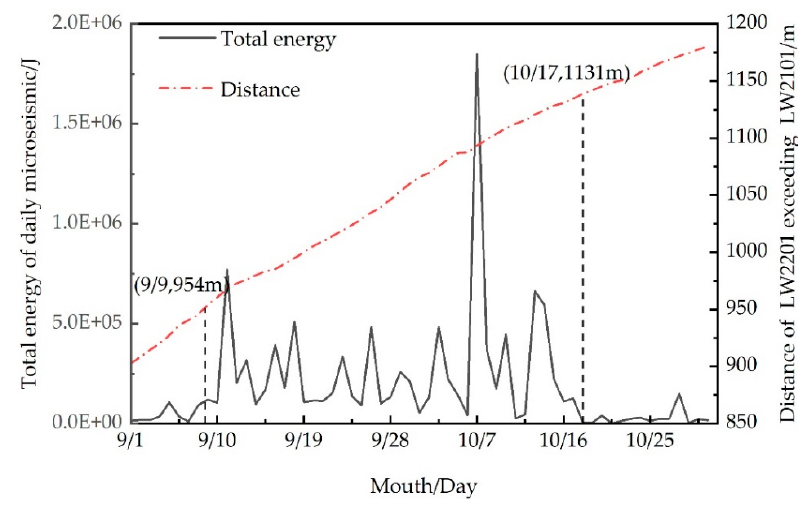
Figure 12. Changing curve of microseismic total energy of the LW2201.